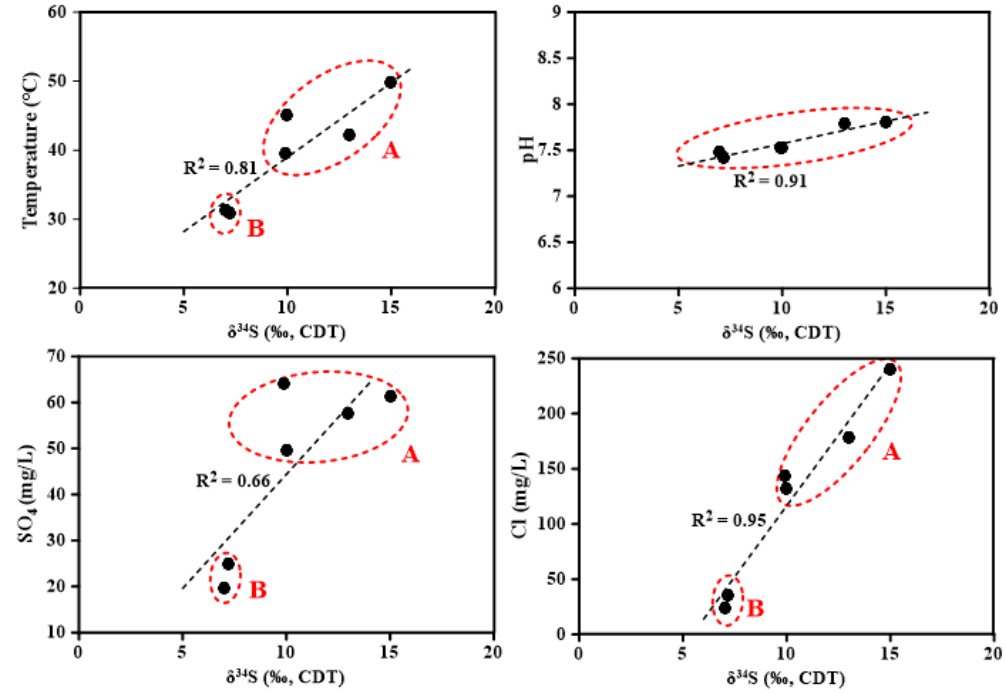
Figure 9. Relationships between chemical composition, temperature, and δ 34 S of the thermal